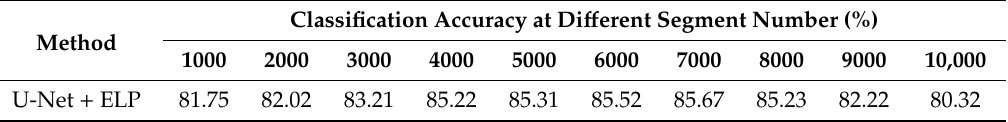
Table 9. Classification accuracy comparison of di ff erent segment